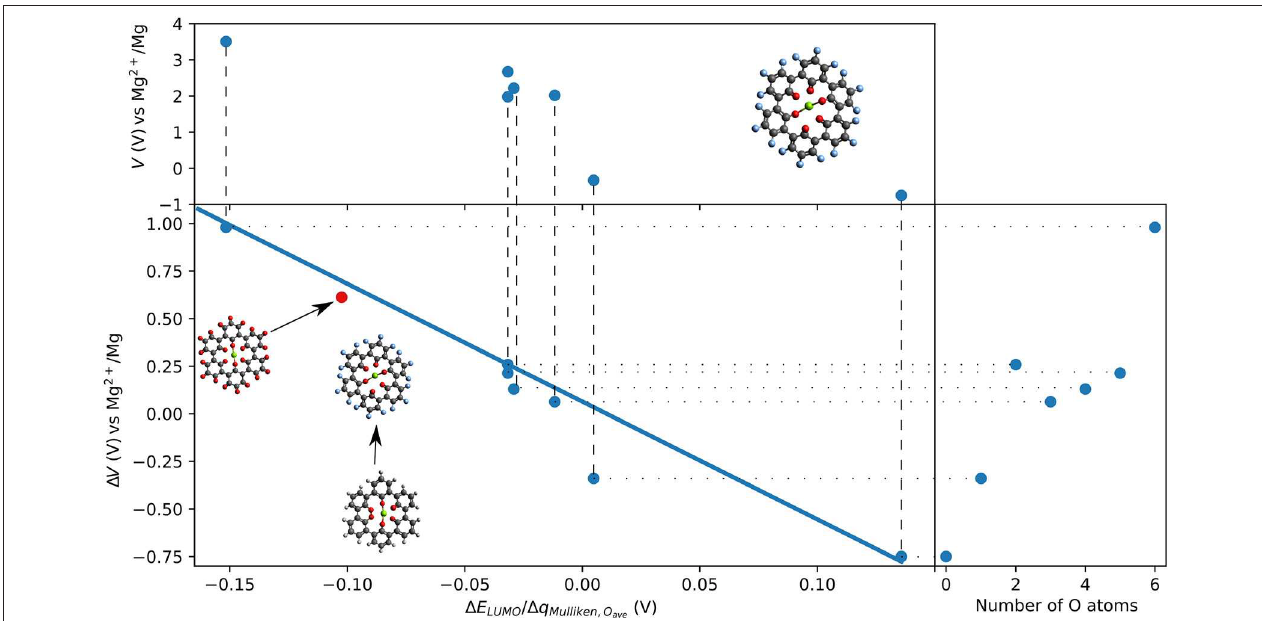
FIGURE 10 | F-functionalization induced changes in voltage vs. Mg 2 + /Mg as a function of the ration of change of LUMO energy and Mulliken charges on O atoms in the inner ring of triple-biphenylene molecule. The insert shows a linear regression (solid blue line). One data point (red dot) shows the result of C 36 O 24 .